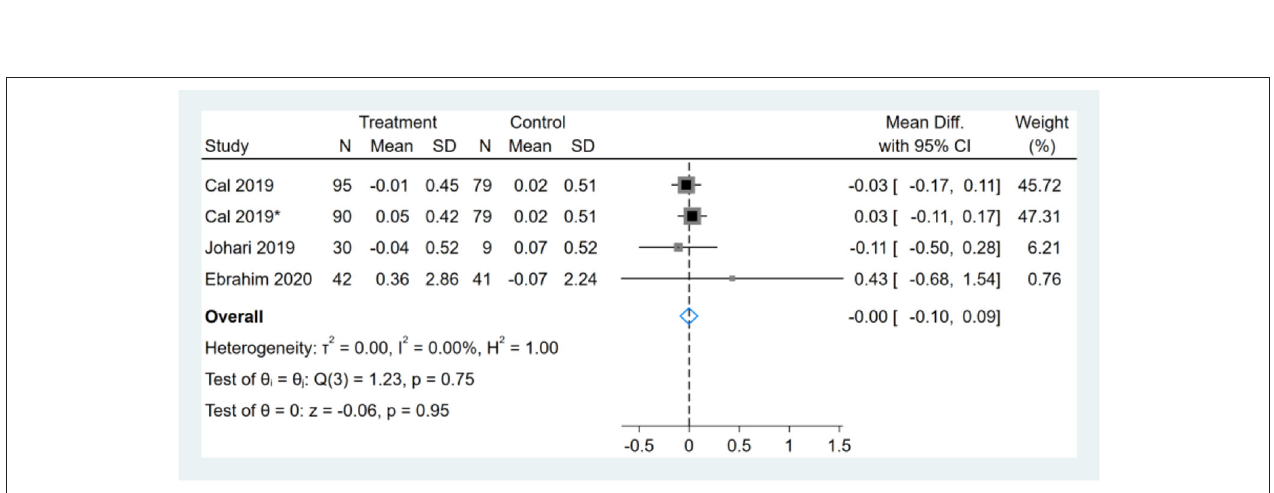
FIGURE 14 | Forest plot analysis showing changes in high-density lipoprotein cholesterol (HDL-C). *This study has two fasting intervention groups.